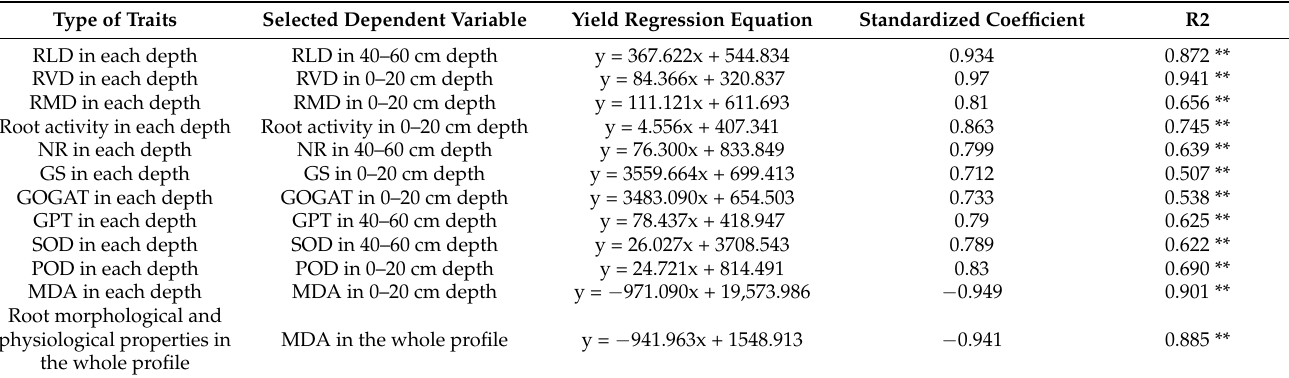
Table 6. Stepwise regression between root traits and